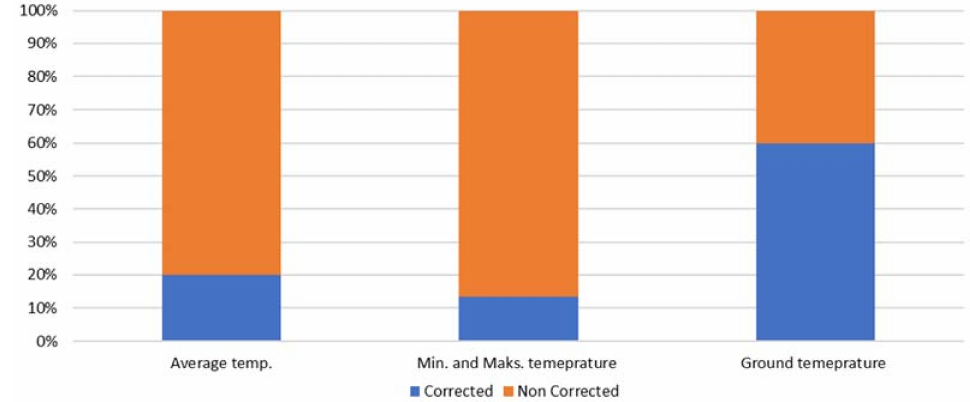
Figure 11. The ratio of models that have improved by adding information from two days back.